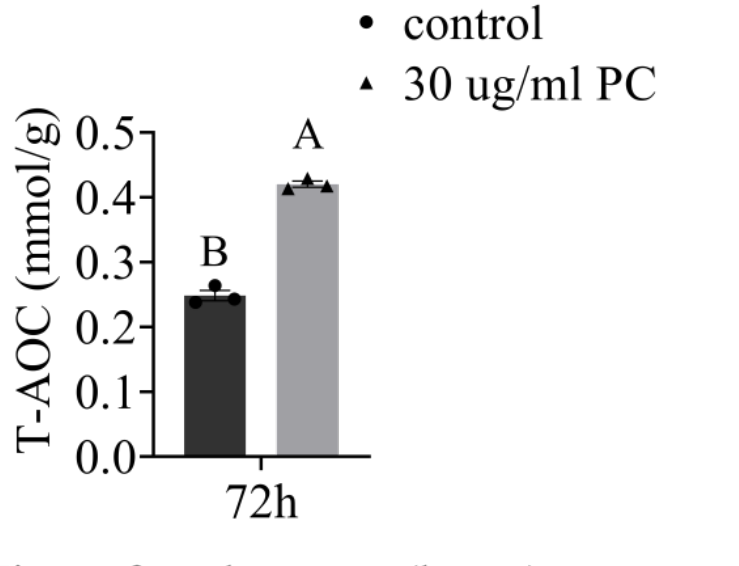
Figure 6. T-AOC of control samples and procyanidin-supplemented dog sperm samples after being stored at a cool temperature for 72 h. Values are expressed as mean ± SEM. Different uppercase superscripts (A and B) indicate significant differences ( p < 0.05).